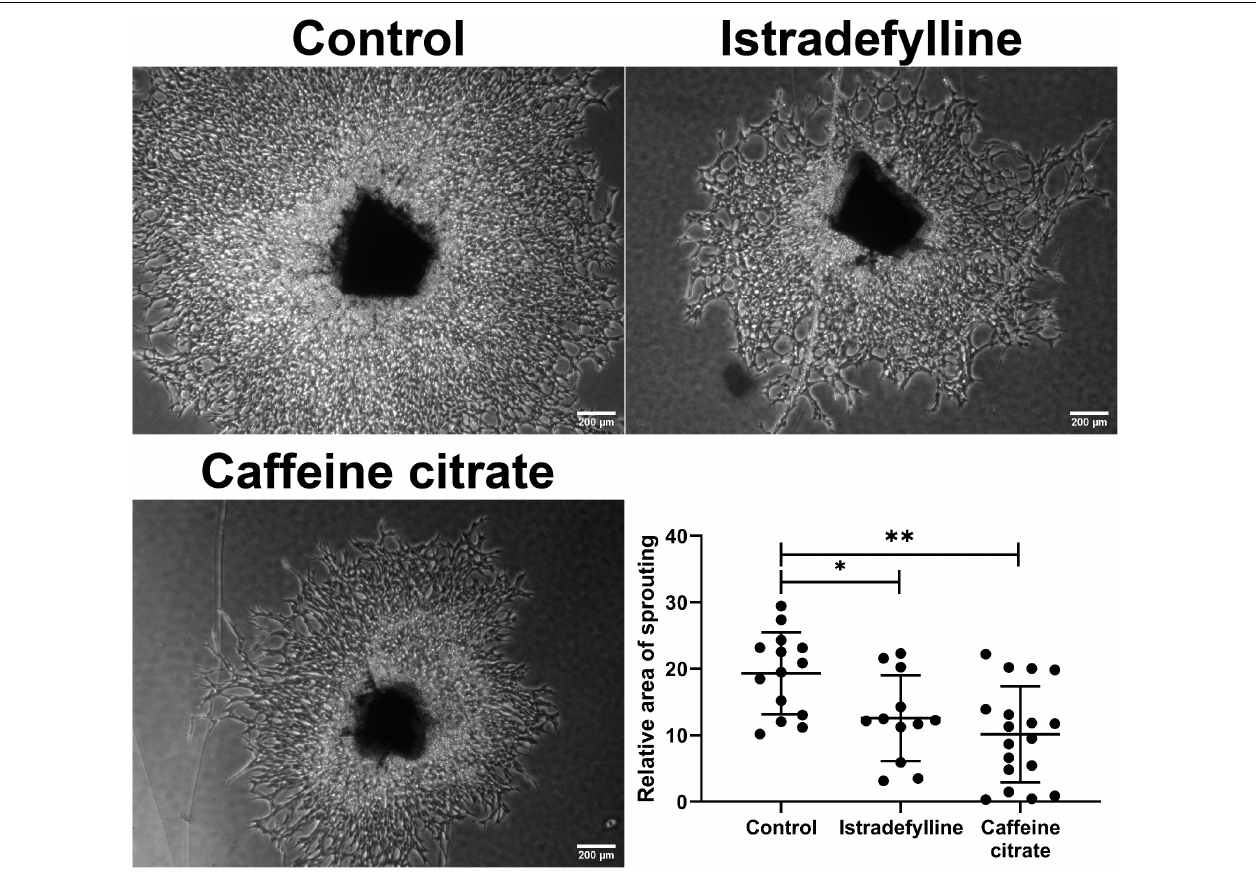
FIGURE 4 | Caffeine mitigates choroid-retinal pigment epithelium (RPE) sprouting in ex vivo culture. Choroid/RPE complex isolated from 4-month-old C57BL/6J mice were grown for 7 days in the presence of vehicle (control), istradefylline (10 µ M) or caffeine citrate (400 µ M), and photographed. Image J was used to assess sprouting area. Scale bar = 200 µ m ( ∗ p < 0.05; ∗∗ p <